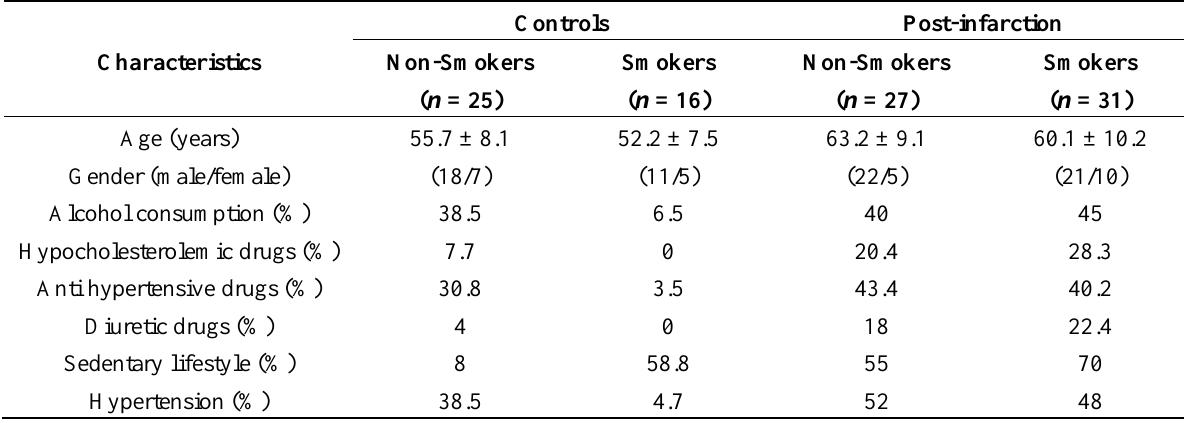
Table 1. Baseline characteristics obtained from controls and subjects after an acute myocardial infarction.